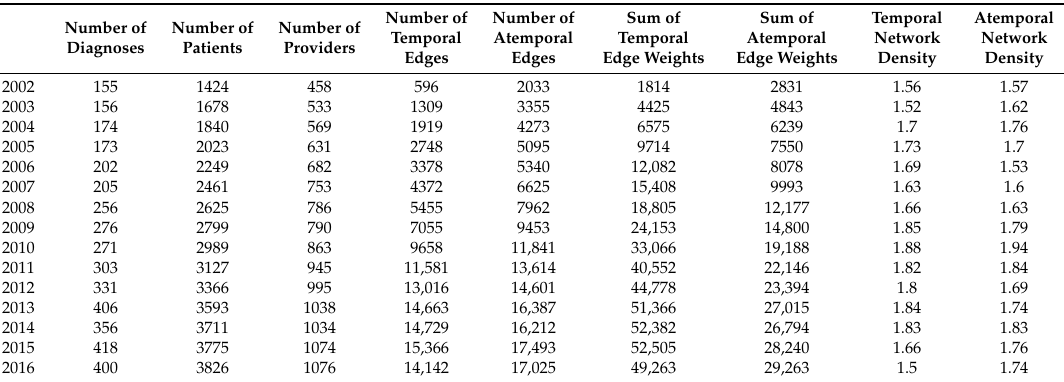
Table 3. Institutional network statistics by year.